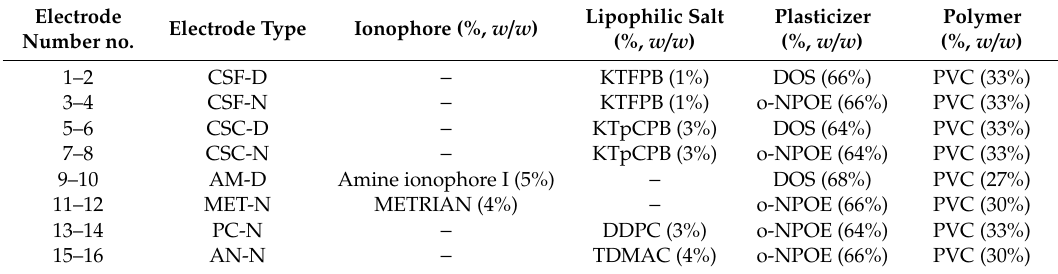
Table 2. Electrodes forming sensor array of the electronic